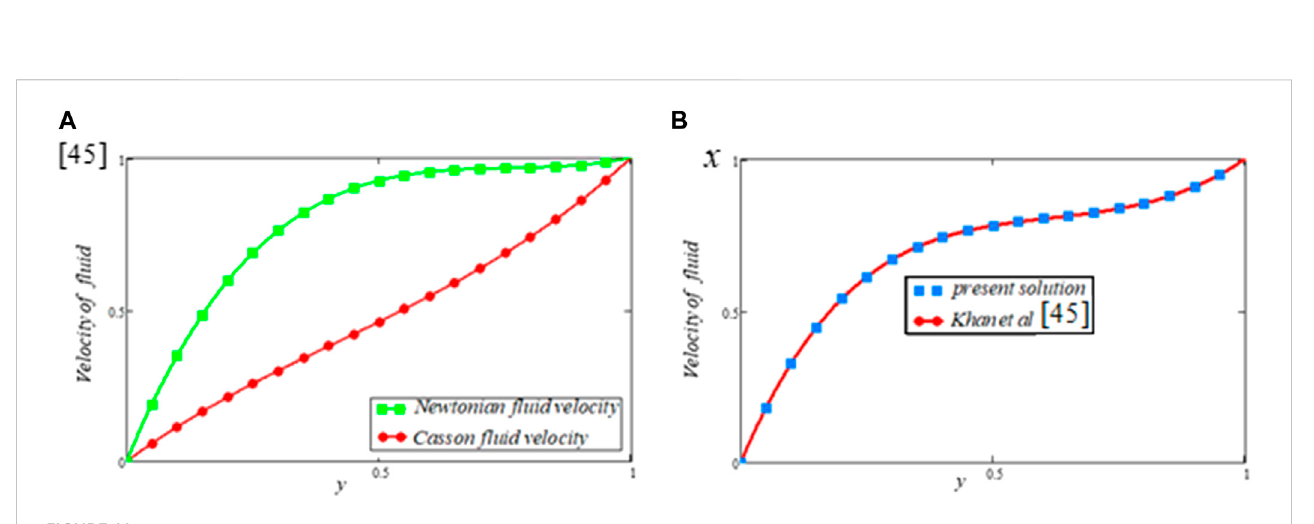
FIGURE 11 Comparison of the present study with (Wahid et al.,